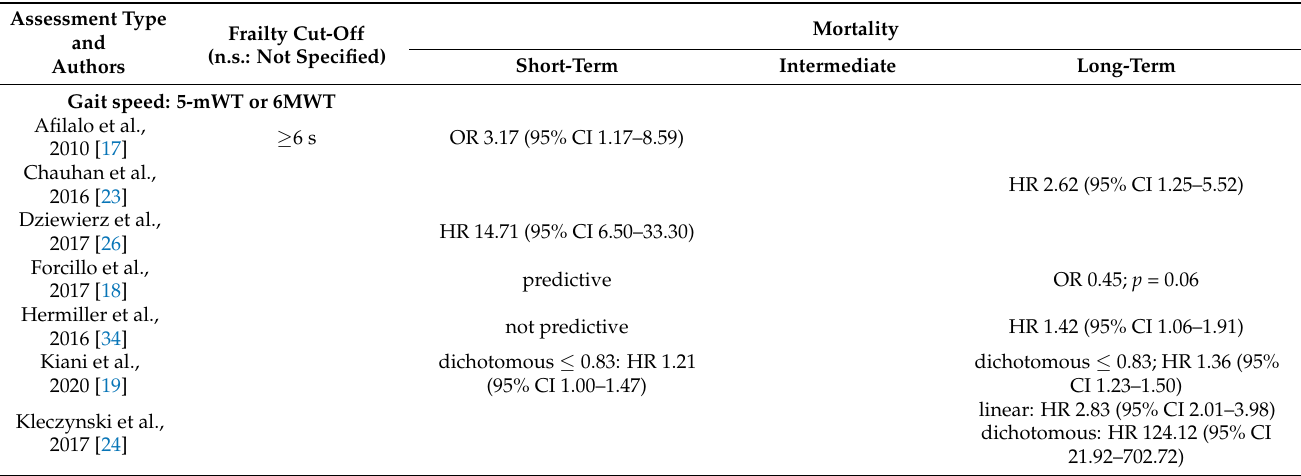
Table 3. Summary of the outcomes (multivariate analysis) of the most-used assessments for all-cause mortality. Assessment Type Frailty Cut-Off and (n.s.: Not Authors